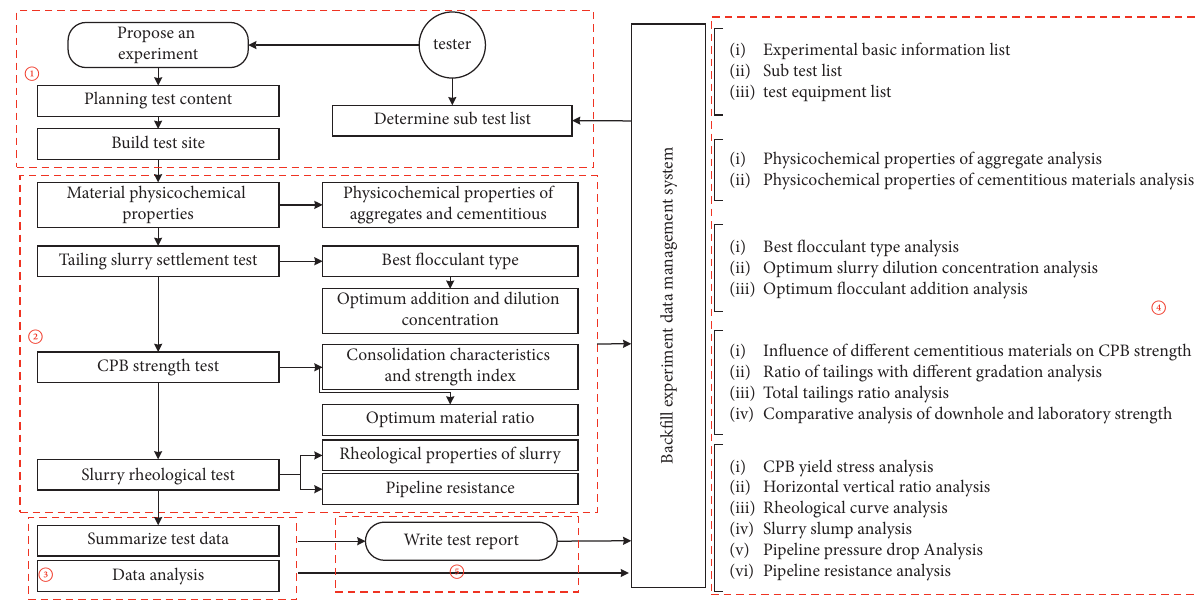
Figure 2: Backfill experiment business model.